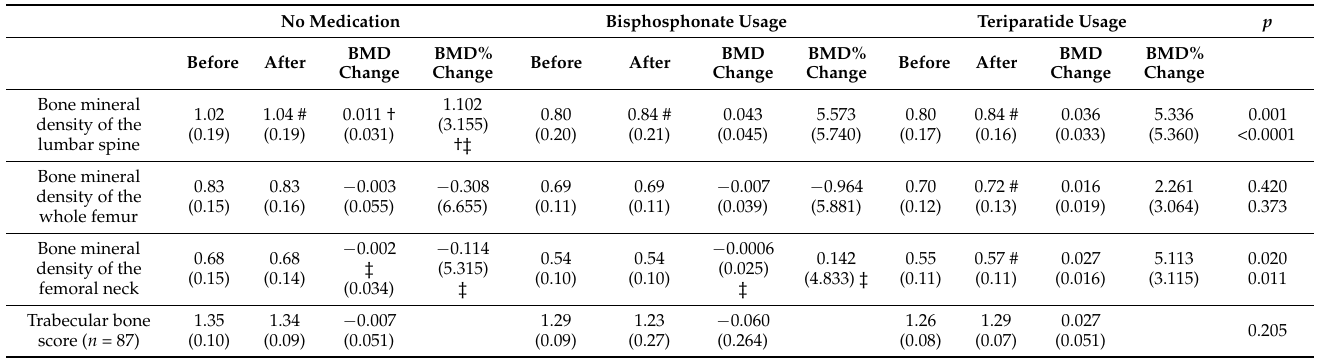
Table 3. The change of bone mineral density or trabecular bone score among the patients who continued to the